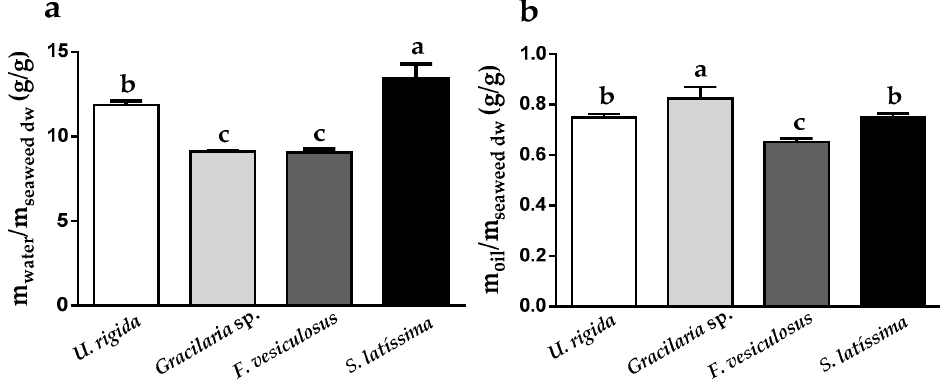
Figure 1. ( a ) water, and ( b ) oil holding capacity of Ulva rigida , Gracilaria sp., Fucus vesiculosus and Saccharina latissima . Different letters in the same graph indicate significant differences ( p < 0.05).